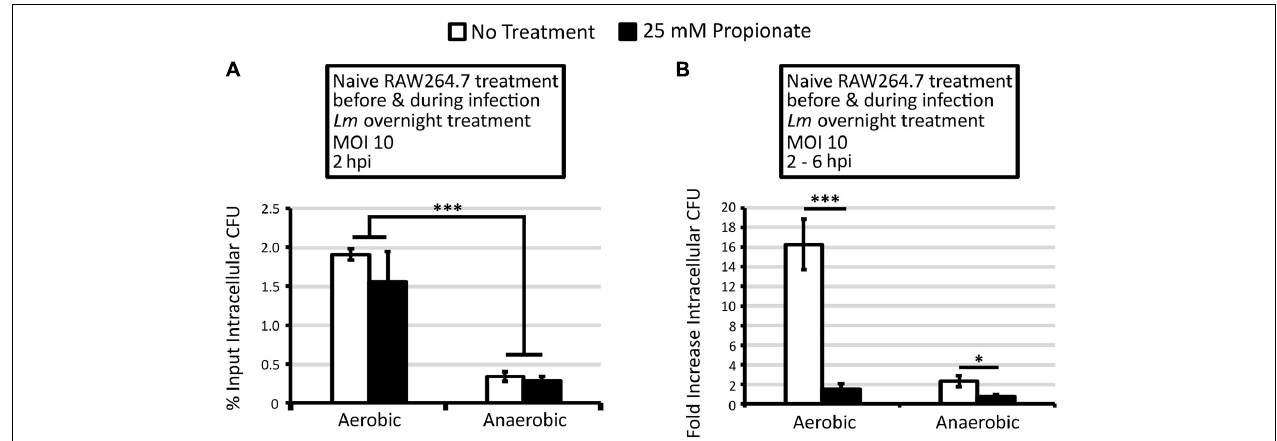
FIGURE 5 | Treatment of macrophages and aerobic or anaerobic L. monocytogenes with 25 mM propionate reduces intracellular growth. L. monocytogenes strain 10403s was grown aerobically or anaerobically with or without 25 mM propionate overnight and rinsed to remove all residual propionate from culture media prior to infections. RAW264.7 macrophages were incubated with or without 25 mM of propionate for 3 h prior to infection and during infections. White bars represent no treatment and black bars represent combined propionate treatment of both L. monocytogenes and macrophages. Infected macrophages were lysed at 2 and 6 hpi to enumerate intracellular CFU. Percent input intracellular CFU (A) was calculated by comparing intracellular CFU at 2 hpi to CFU in the infection inoculum. Fold increase intracellular CFU (B) was calculated by comparing intracellular CFU between 2 and 6 hpi. Averages from 3 independent experiments, each performed in triplicates, were plotted with error bars representing standard errors of the mean (A,B) . Asterisks denote statistical significance between pair-wise comparisons with ∗ p < 0.05 and ∗∗∗ p <